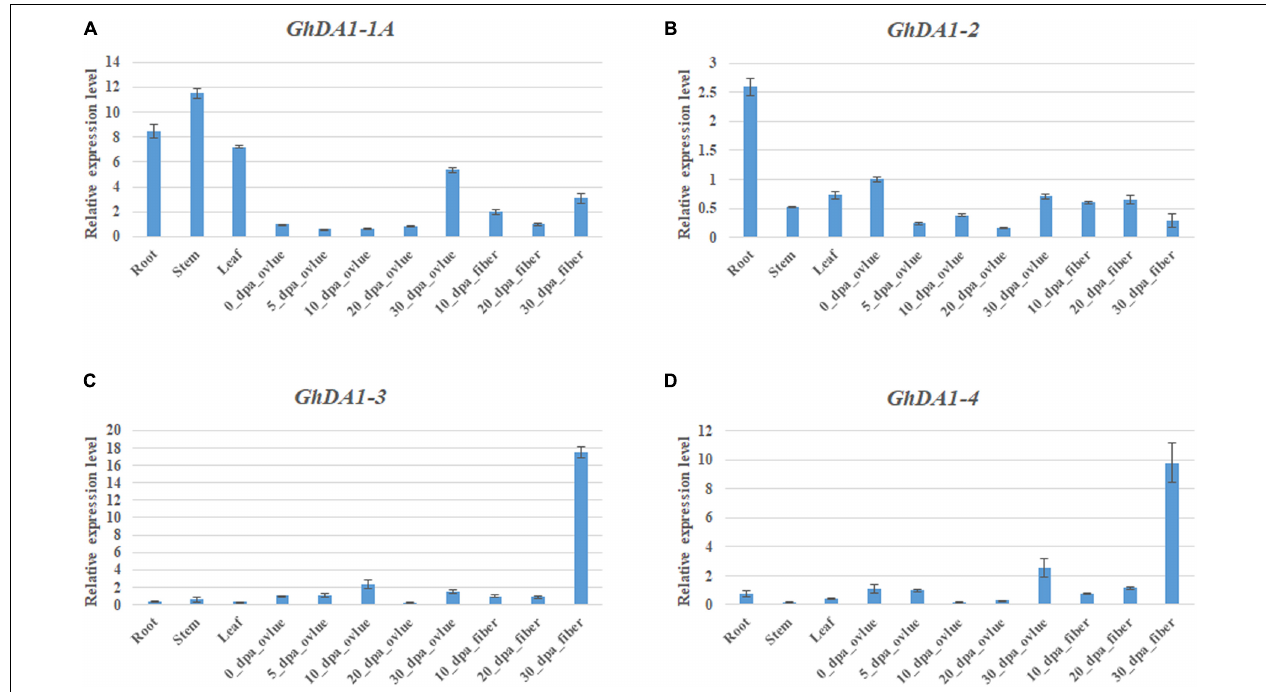
FIGURE 3 | Tissue-specific expression profiles of GhDA1s in different tissues of G. hirsutum accession TM-1. (A) Relative expression level of GhDA1-1A . (B) Relative expression level of GhDA1-2A and GhDA1-2D . (C) Relative expression level of GhDA1-3A and GhDA1-3D . (D) Relative expression level of GhDA1-4A and GhDA1-4D . The (cid:49) C t value of GhDA1 in 0-DPA-ovules was set as the control. The data presented are the means ± SD of three replicates.